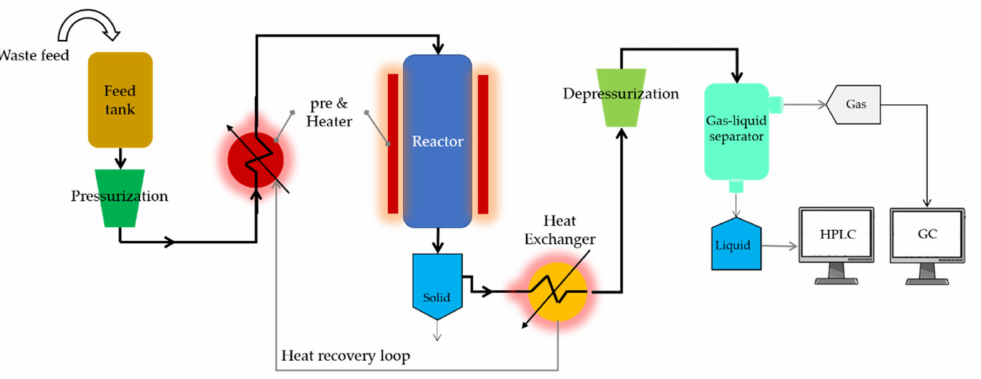
Figure 3. Schematic representation of a continuous flow SCW